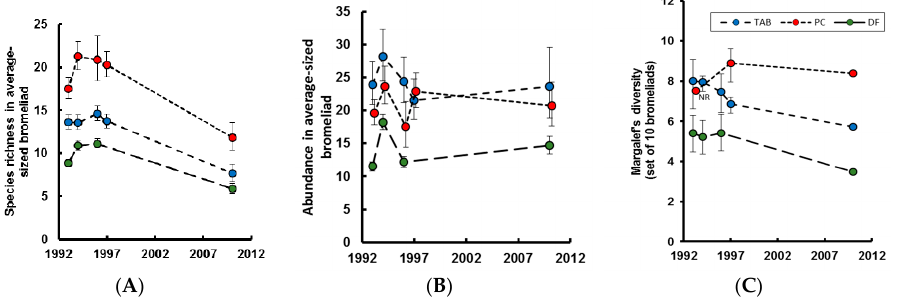
Figure 1. Changes in bromeliad invertebrate communities over time. Predicted means with 95% confidence intervals (for details see [6]). ( A ) Species richness; ( B ) Animal abundance; ( C ) Gamma diversity. See [7]. NR = no replication for this data point; TAB = Tabonuco; PC = Palo colorado; DF = Elfin forest.